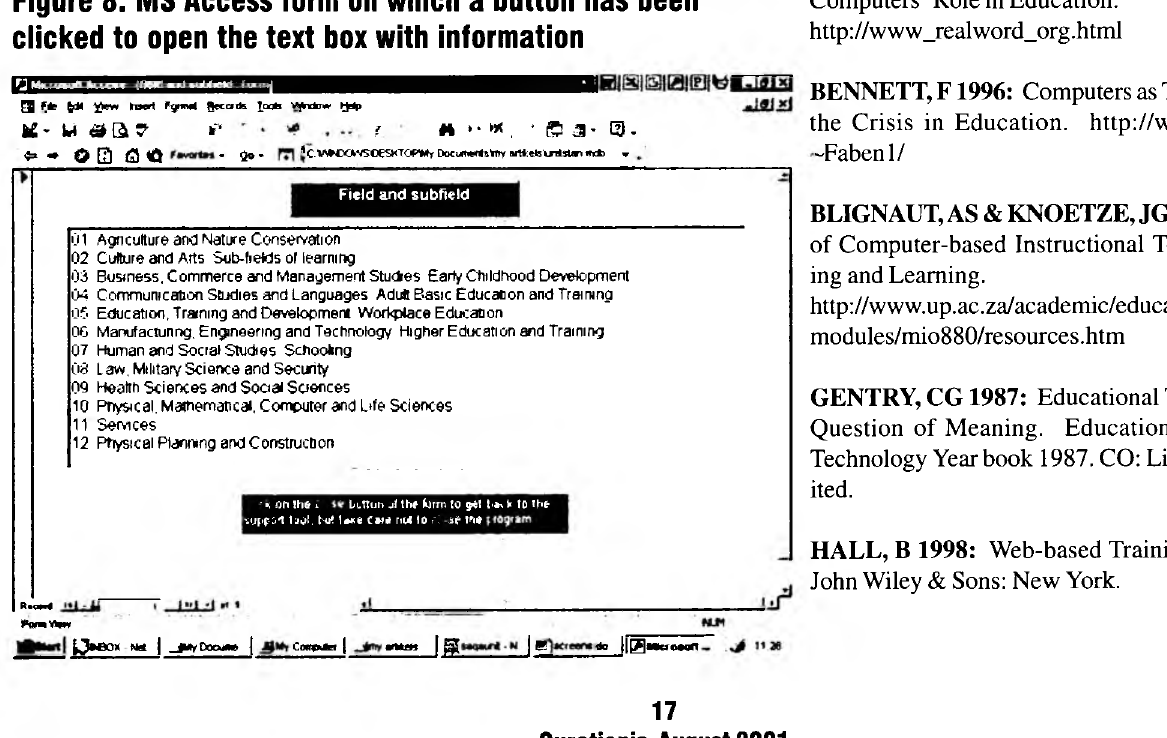
Figure 8: MS Access form on which a button has been clicked to open the text box with